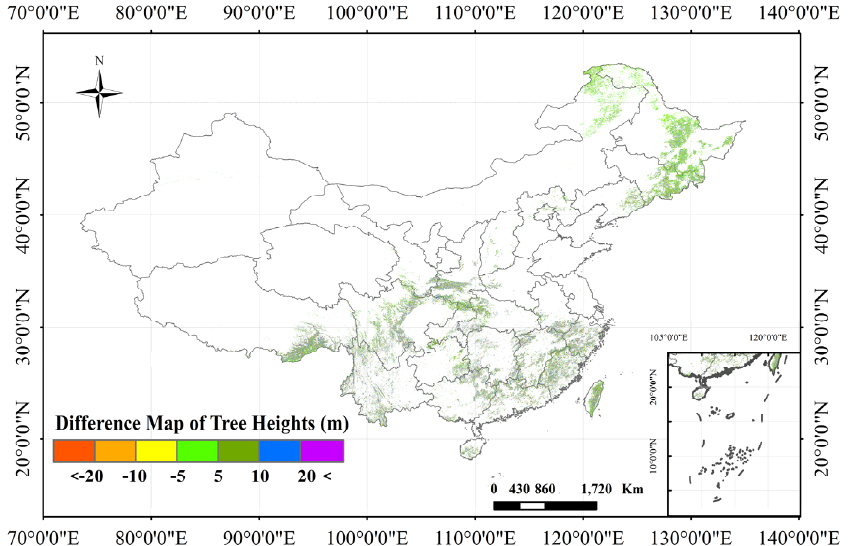
Figure 6. The difference map of modeled tree heights with averaged GLAS tree